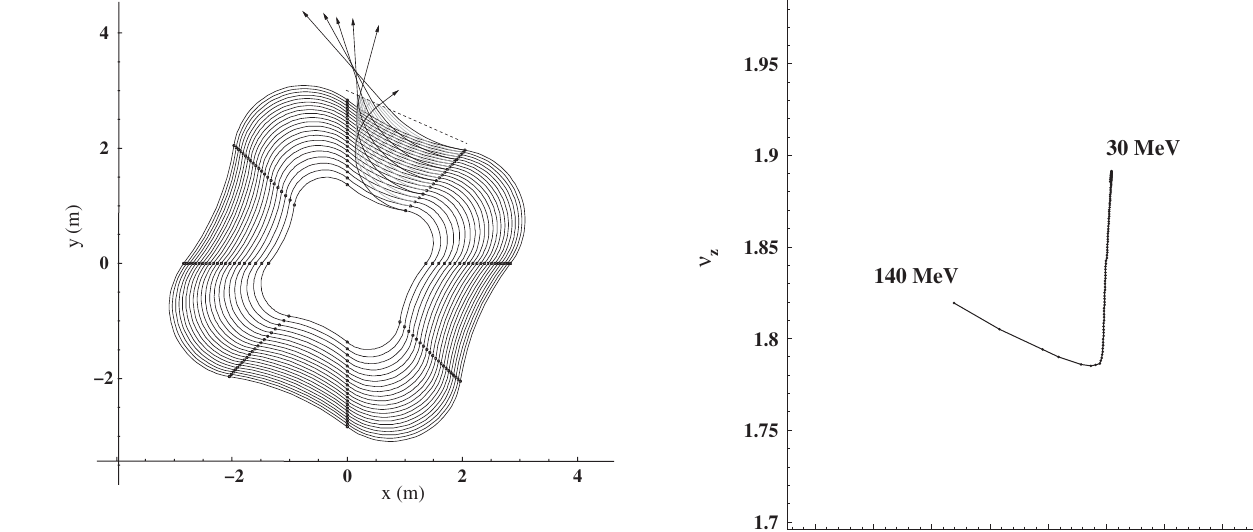
FIG. 2. Geometry of a H þ 2 cyclotron for isotope production with reverse bends. The H þ 2 beam is stripped at the sector edge (indicated by symbols). The orbits of stripped proton beams are shown from 15 to 70 MeV in steps of 2.75 MeV. The arrows indicate the extracted beams for 15, 26, 37, 48, 59, and 70 MeV. The dashed line is the field edge of the reverse bend.